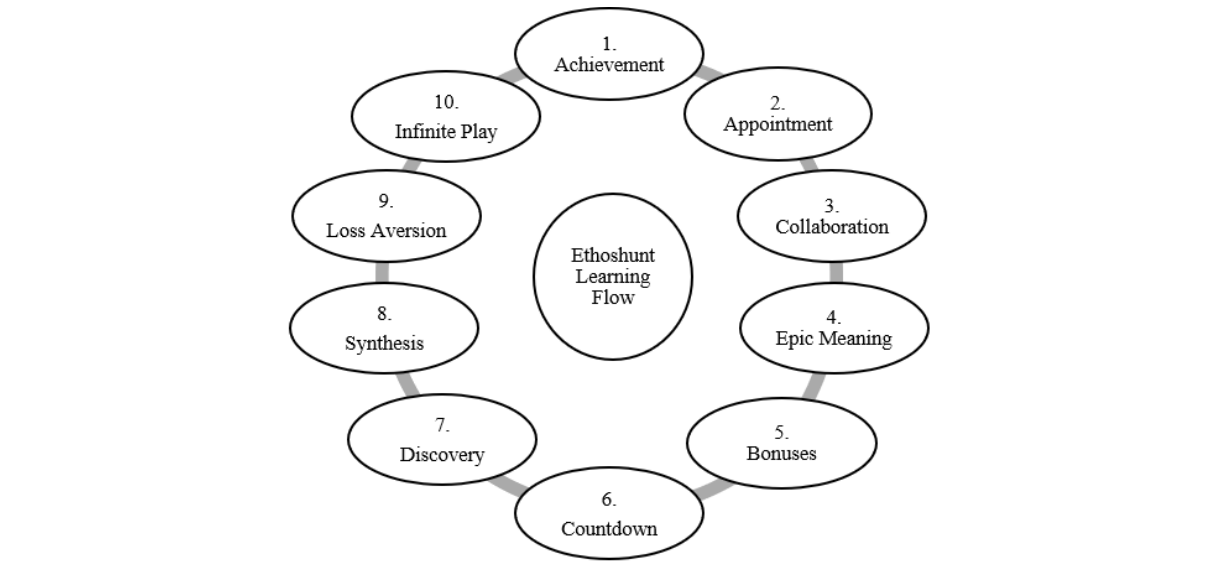
Figure 4. Learning flow through Ethoshunt.